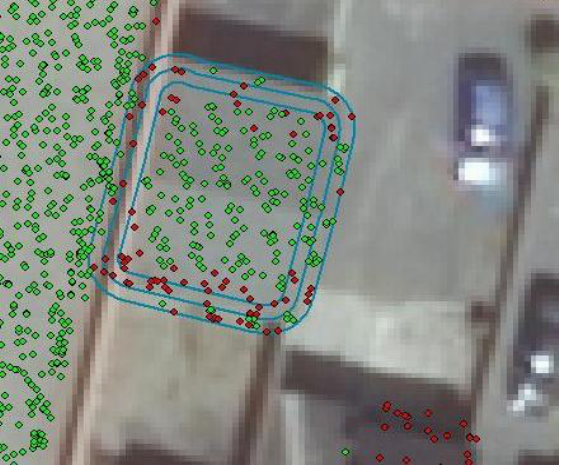
Figure 5. Using 1.5 m as cutoff for small houses helps captures the majority of correct roof points (green) in the roof area and leaves the noise for outer rings.